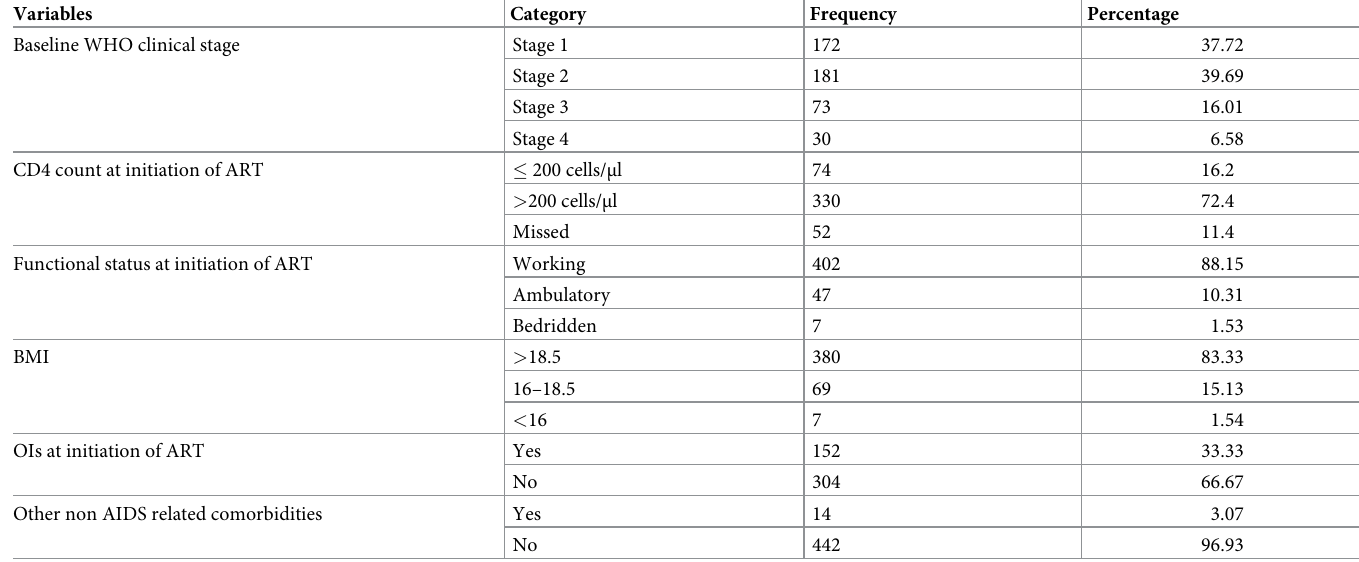
Table 3. Clinical and immunological characteristics of HIV positive adults at initiation of HAART at Arba Minch town public health facilities, January 2013 to December 2018 (N = 456).